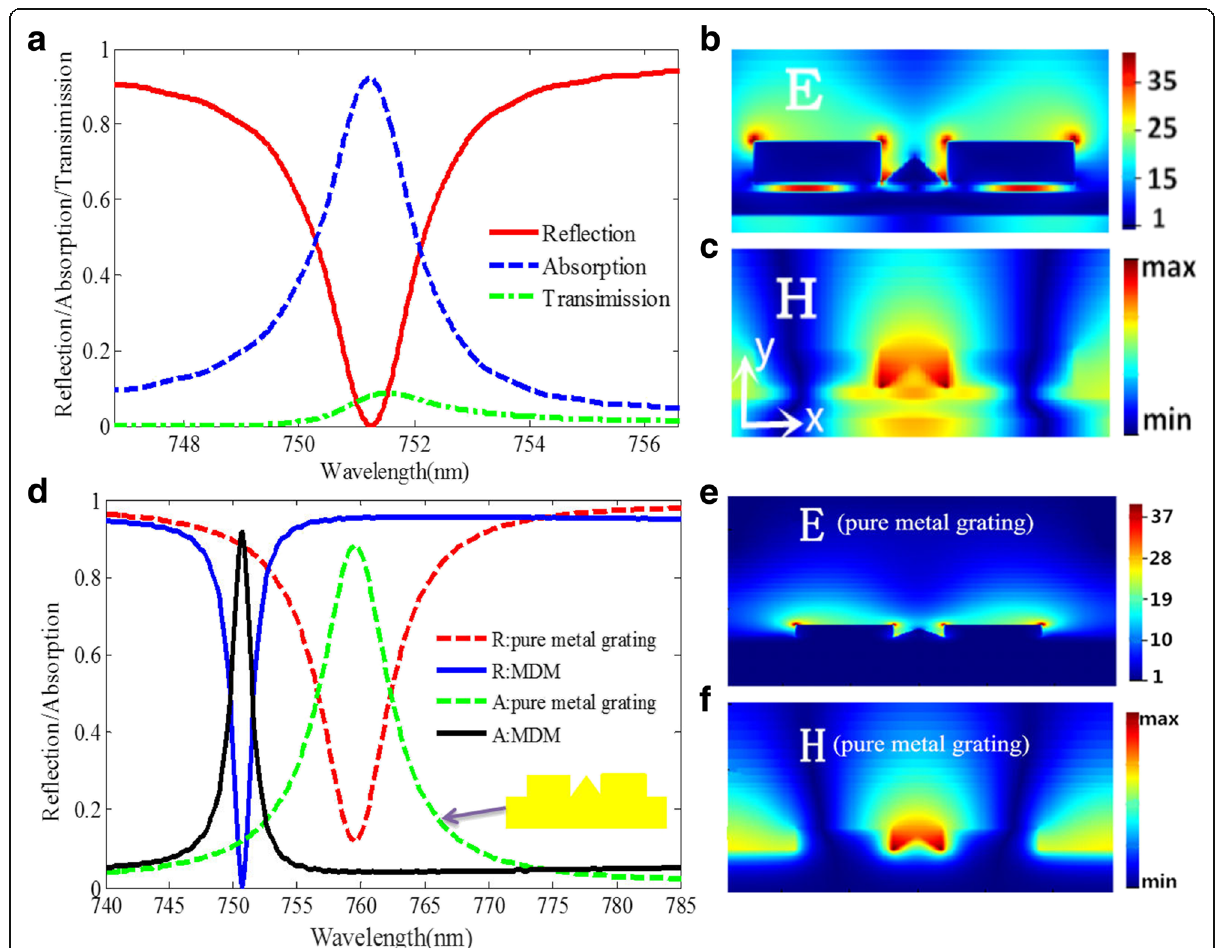
Fig. 3 a Absorption, reflection, and transmission spectra of the proposed structure. b Distributions of the electric field E of the MDM structure at resonant peak. c Distributions of the magnetic field H of the MDM structure at resonant peak. d The reflection and absorption spectra of the MDM structure and pure metal grating structure. e Distributions of the electric field E of the pure metal grating structure at resonant peak. f Distributions of the magnetic field H of the pure metal grating structure at resonant